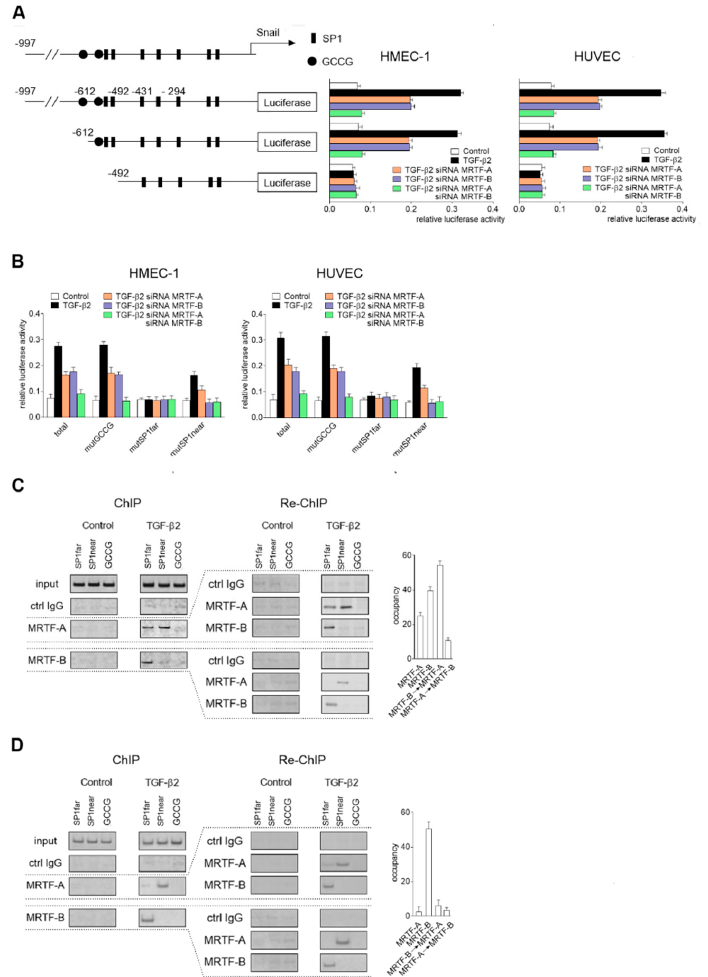
Figure 7. Direct MRTF-A and MRTF-B cooperation is required for complete regulation of snail expression in TGF- β 2-induced EndMT. HMEC-1 cells and HUVECs were incubated with TGF- β 2 (10 ng / mL) for 48 h. As the control, non-stimulated cells were used. Subsequently, ( A ) Snail luciferase constructs were studied in MRTF-A-, MRTF-B-, or both MRTFs silenced (MRTF-A–MRTF-B-silenced) HMEC-1 cells or HUVECs. The following constructs were used: − 997 / 90, − 612 / 90, and − 492 / 90. ( B ) Snail luciferase constructs with mutations in CGGC or SP1 fragments were analyzed in MRTF-A-, MRTF-B-, or MRTF-A–MRTF-B-silenced HMEC-1 cells or HUVECs. The constructs with mutGCCG, mutSP1far, and mutSP1near were made as indicated previously. ( C ) HMEC-1 cells were incubated with TGF- β 2 or TGF- β 1 (10 ng / mL) for 24, 48, 60, and 72 h. As the control, non-induced cells were applied. Subsequently, the Snail luciferase construct (-997 / 90) was studied in MRTF-A-, MRTF-B-, or MRTF-A–MRTF-B-silenced HMEC-1 cells. For ( A ) and ( B ), results are given as the standard error of the mean of the relative luciferase activity ( N = 3). Then, a chip assay was performed in the HMEC-1 cells incubated with TGF- β 2 (10 ng / mL) for 48 ( C ) or 72 h ( D ). Chromatin was fragmented and immunoprecipitated with normal rabbit IgG, anti-MRTF-A, and anti-MRTF-B antibodies. For the Re-Chip assay, immunoprecipitated DNA was diluted 10 times and re-immunoprecipitated with normal rabbit IgG, anti-MRTF-A, and anti-MRTF-B antibodies. Immunoprecipitated and re-immunoprecipitated DNA was amplified by PCR and separated on an agarose gel and visualized. Representative inverted gel images are shown. The results are presented as the means ± SD ( N = 3).